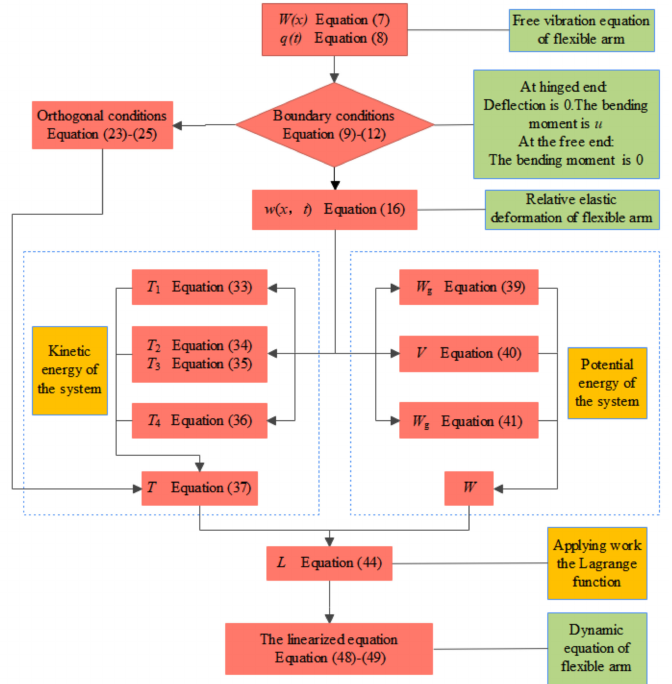
Figure 5. Calculation flow